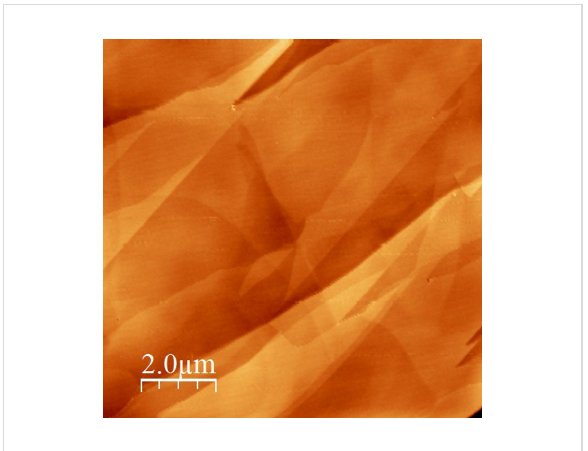
Figure 7: AFM 10 × 10 μ m 2 topography image of the as-exfoliated HOPG sample. The surface appears clean and several steps can be observed.